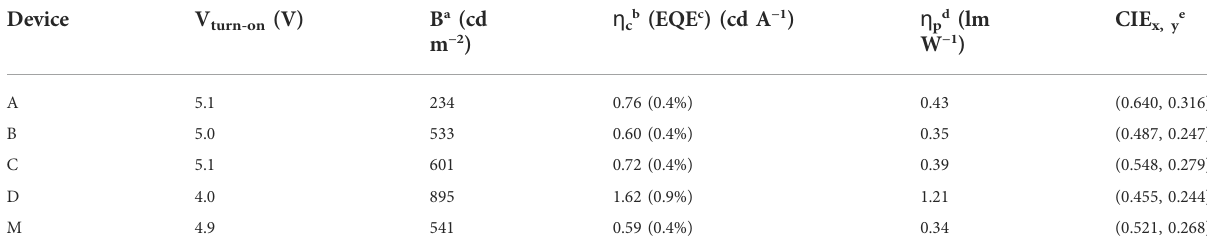
TABLE 1 The key properties of devices A, B, C, D, and M. Device